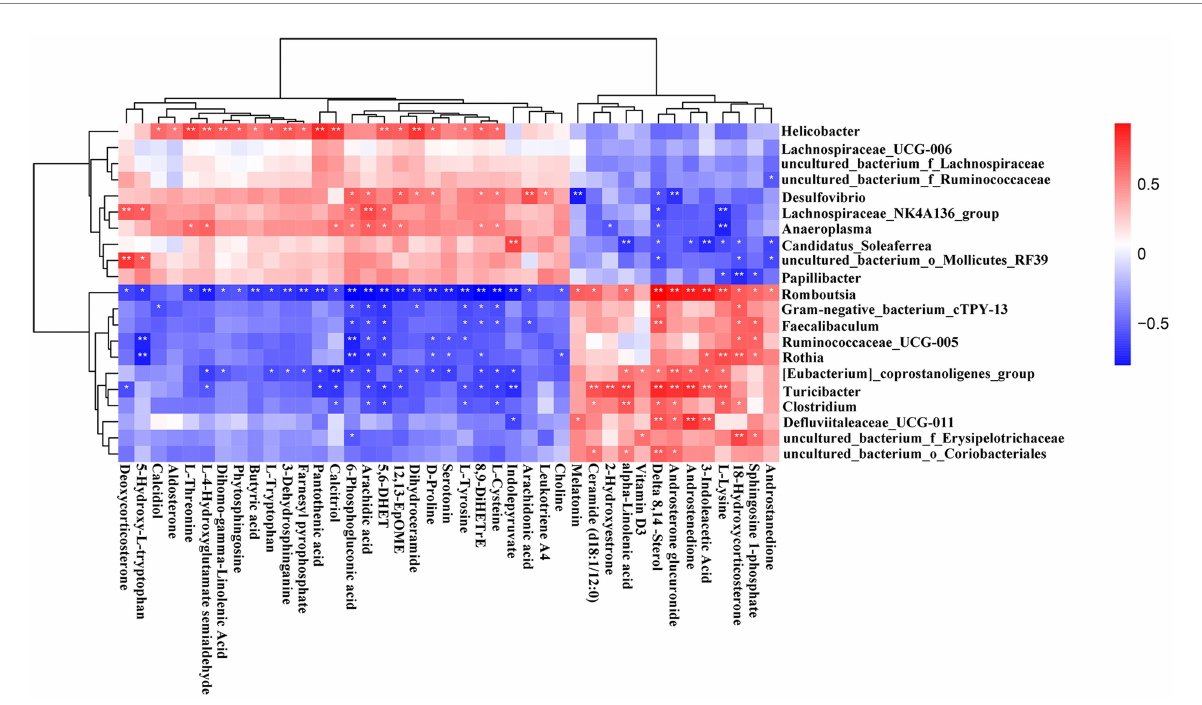
FIGURE 12 Correlation heatmap of differential microbiota and serum metabolites. Data were calculated by Spearman’s correlation method after mean centering and unit variance scaling. * p < 0.05, ** p <